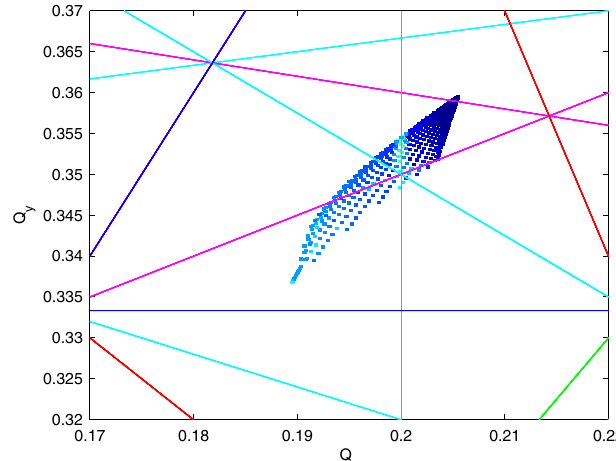
FIG. 1. Detuning with relative momentum deviation: compari- son of measured to model